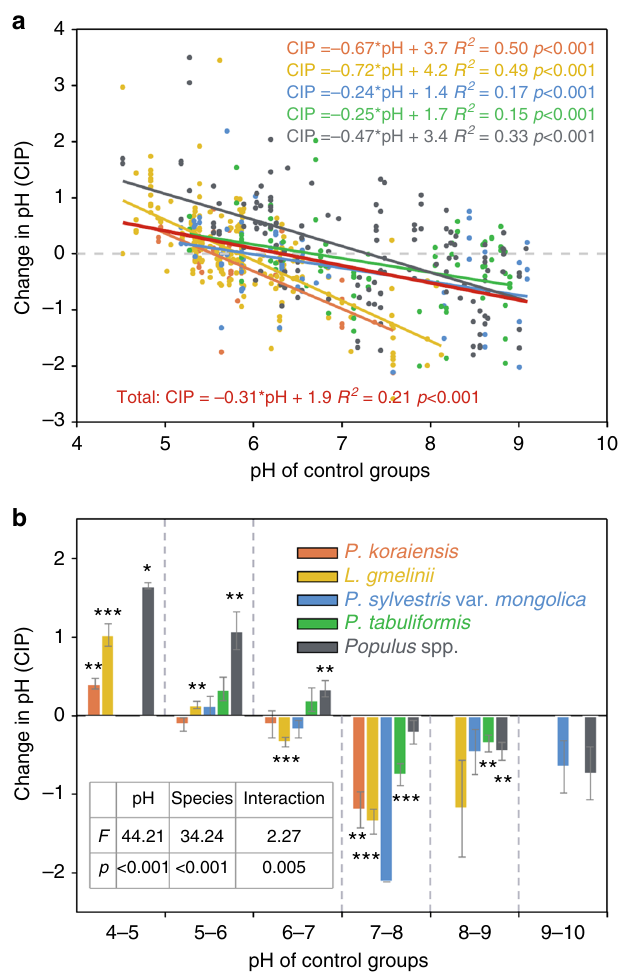
Fig. 4 Relationships between change in soil pH and initial pH across fi ve plantation tree species. a Plotting of change in soil pH (CIP) against initial soil pH for each of the fi ve plantation species. Solid lines indicate the ordinary least squares (OLS) fi t of the linear equation (CIP = a *pH+ b , where pH indicates the pH of the control group) for each of the fi ve plantation species (the colors are the same as the legend in b ) and all the species pooled together. b The dependence of mean CIP on initial soil pH across the fi ve plantation species. Mean CIP is averaged for each unit of initial soil pH. Error bars indicate standard errors. Independent sample t -tests with false discovery rate (FDR) correction were conducted to compare data of each group with 0. Symbols *, **, and *** indicate that the null hypothesis could be rejected at a signi fi cance level of 0.05, 0.01, and 0.001, respectively. The inset shows the results of two-way ANOVA on the effect of initial soil pH and species on CIP. Interaction indicates initial soil pH ×